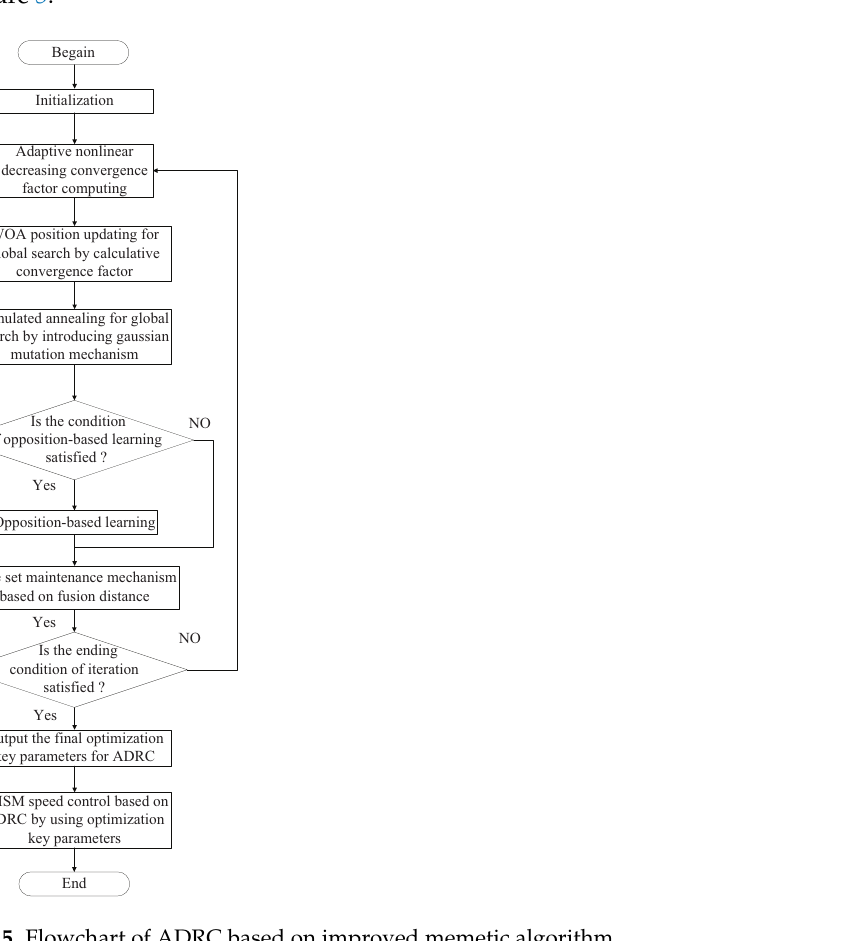
Figure 5. Flowchart of ADRC based on improved memetic